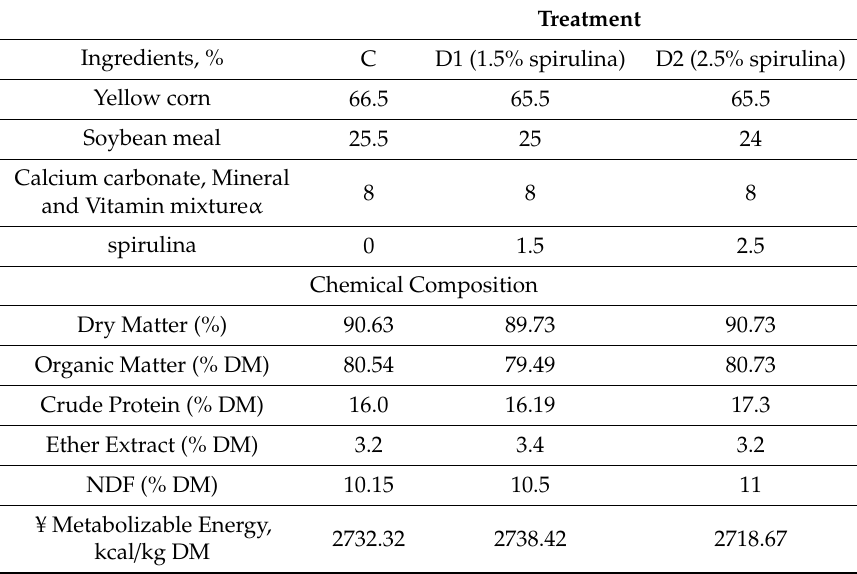
Table 1. Ingredients and chemical composition of